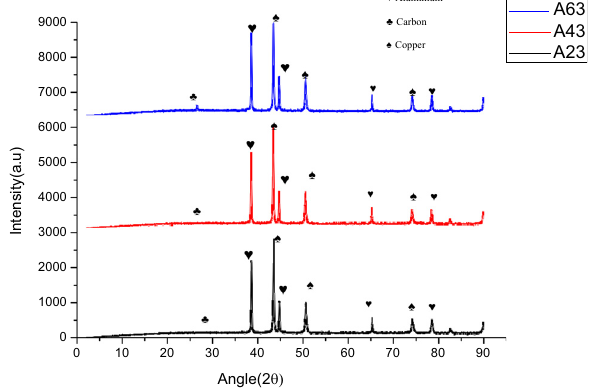
Figure 7: XRD data of pristine and composite materials recorded at room